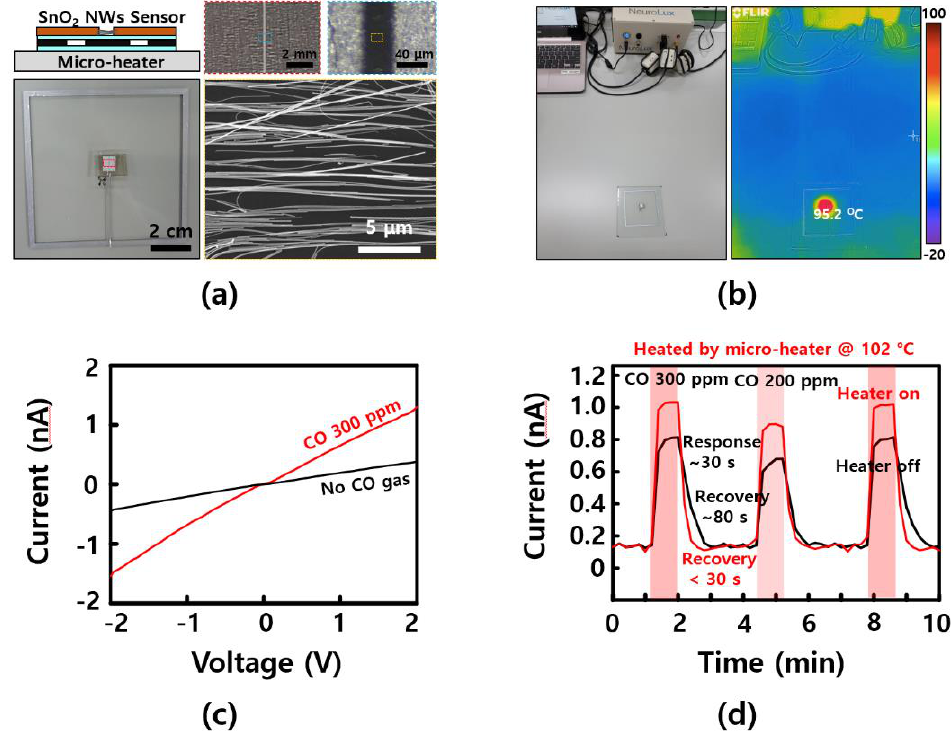
Figure 5. Micro-heater for CO–gas–sensing applications. ( a ) Images of a SnO 2 nanowire gas sensor device; ( b ) photograph and IR image of a wirelessly operated micro-heater with a SnO 2 nanowire gas sensor; ( c ) current–voltage (IV) curve of a SnO 2 nanowire device without CO gas (black line) and with 300 ppm CO gas (red line); and ( d ) current on the SnO 2 nanowire as a function of the CO gas level without a heater (black line) and with a heater (red line).